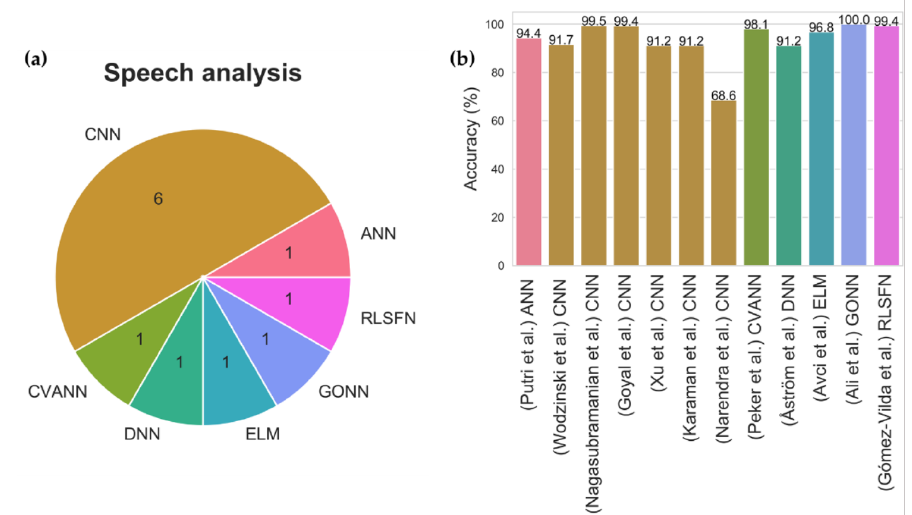
Figure 11. ( a ) Pie chart representation of various deep learning models proposed for speech analysis and, ( b ) bar chart representation of model accuracy for each deep learning study in speech